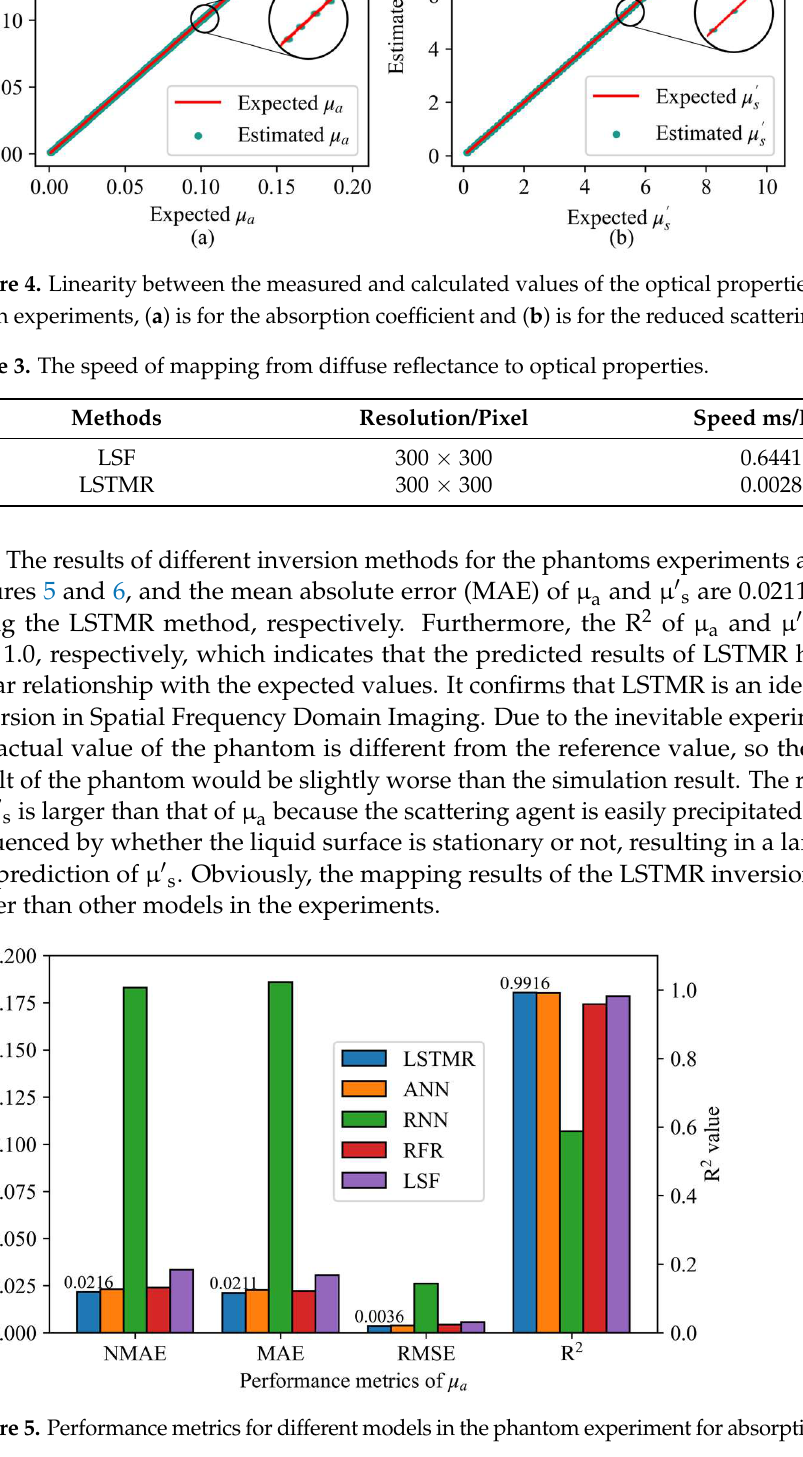
Figure 6. Performance metrics for different models in the phantom experiment for reduced scatter- ing coefficient. 3.3. Pear Experiment Results The results of the bruised tissue detection experiment for pears are shown in Figures 7 and 8. Pears will form bruised tissue at an early stage after being slightly crushed. In this study, it was demonstrated that bruised tissue forms on the surface of the pear after a slight impact. The absorption coefficient of the tissue increases during the formation of bruised tissue. The opposite is true for the reduced scattering coefficient, which is con- sistent with the experimental results of Sun [25] and Luo [35]. Moreover, both absorption and reduced scattering images could highlight the areas of bruised tissue. Therefore, us- ing the Spatial Frequency Domain Imaging technique, early bruised detection of fruits can be performed. Furthermore, it can effectively control the bruised of fruits during trans- portation, thus controlling the cost of the fruit industry. The optical properties (OPs) of apple tissues can be used for nondestructive quality or ripeness prediction of apples [4], and the Long Short-term Memory method proposed in this study can obtain prediction results more accurately and quickly. Therefore, the rapid acquisition of OPs in tissues is of particular importance. This further illustrates the need to improve the speed and accu- racy of extracting the OPs of tissues. It also lays the foundation for the real-time, portable acquisition of tissue OPs.